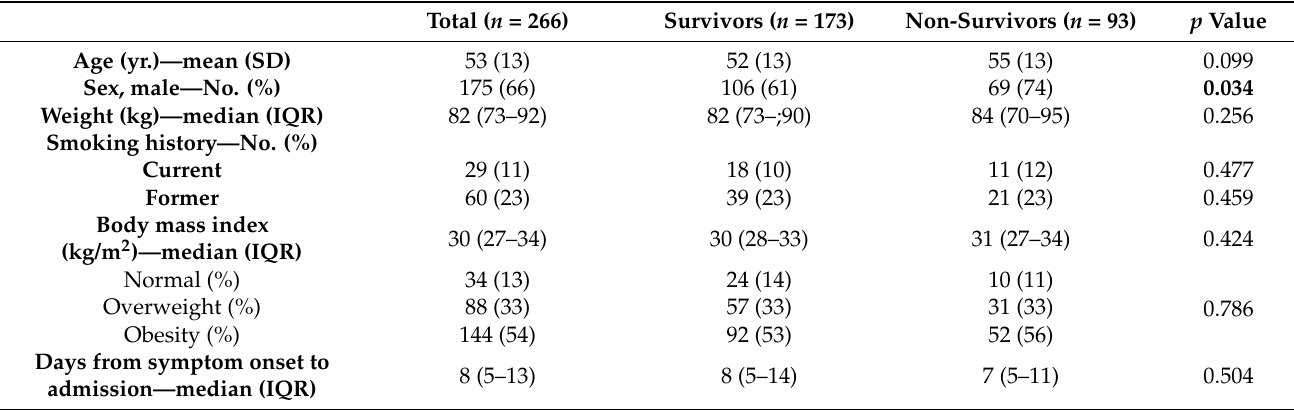
Table 1. Clinical characteristics and outcomes of COVID-19